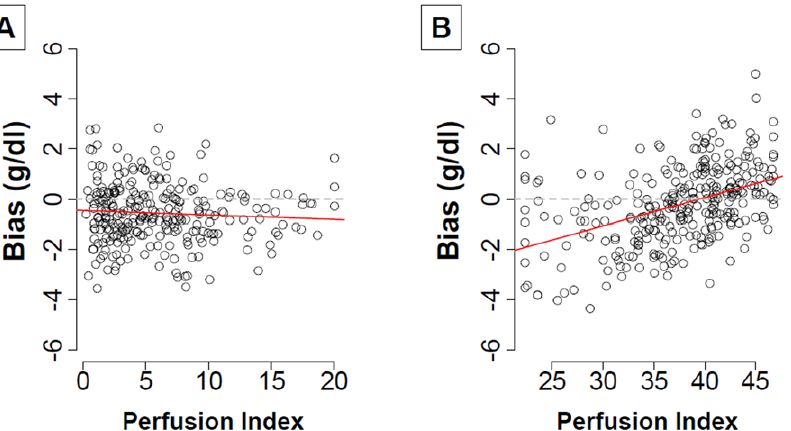
Figure 5. Association between perfusion index and bias. Results for the Pronto-Study are displayed on the panel A and for the Orsense-Study on the panel B. The red line represents the linear regression relationship between the perfusion index and the bias. Perfusion index is linearly correlated with the bias in Orsense-Study but not in the Pronto-Study (Spearman correlation coefficients at - 0.06, p=0.36 and 0.42, p , 0.0001 for the Pronto-Study and Orsense-study, respectively).